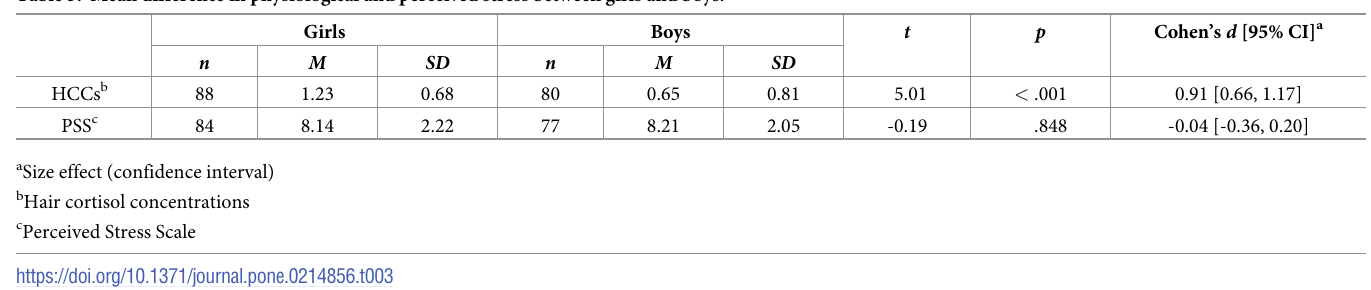
Table 3. Mean difference in physiological and perceived stress between girls and boys.